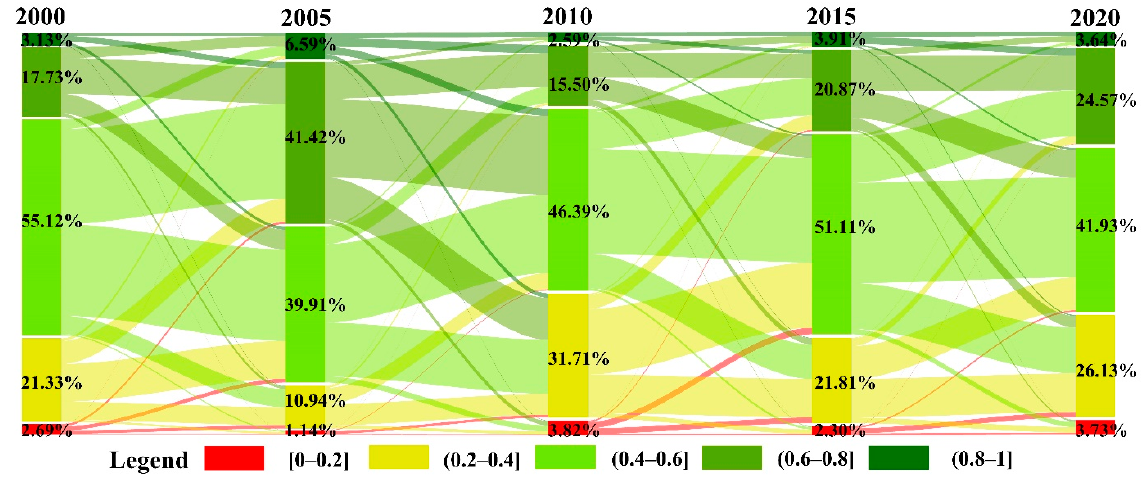
Figure 7. WIRSEI transformation matrix for 2000, 2005, 2010, 2015, and 2020.